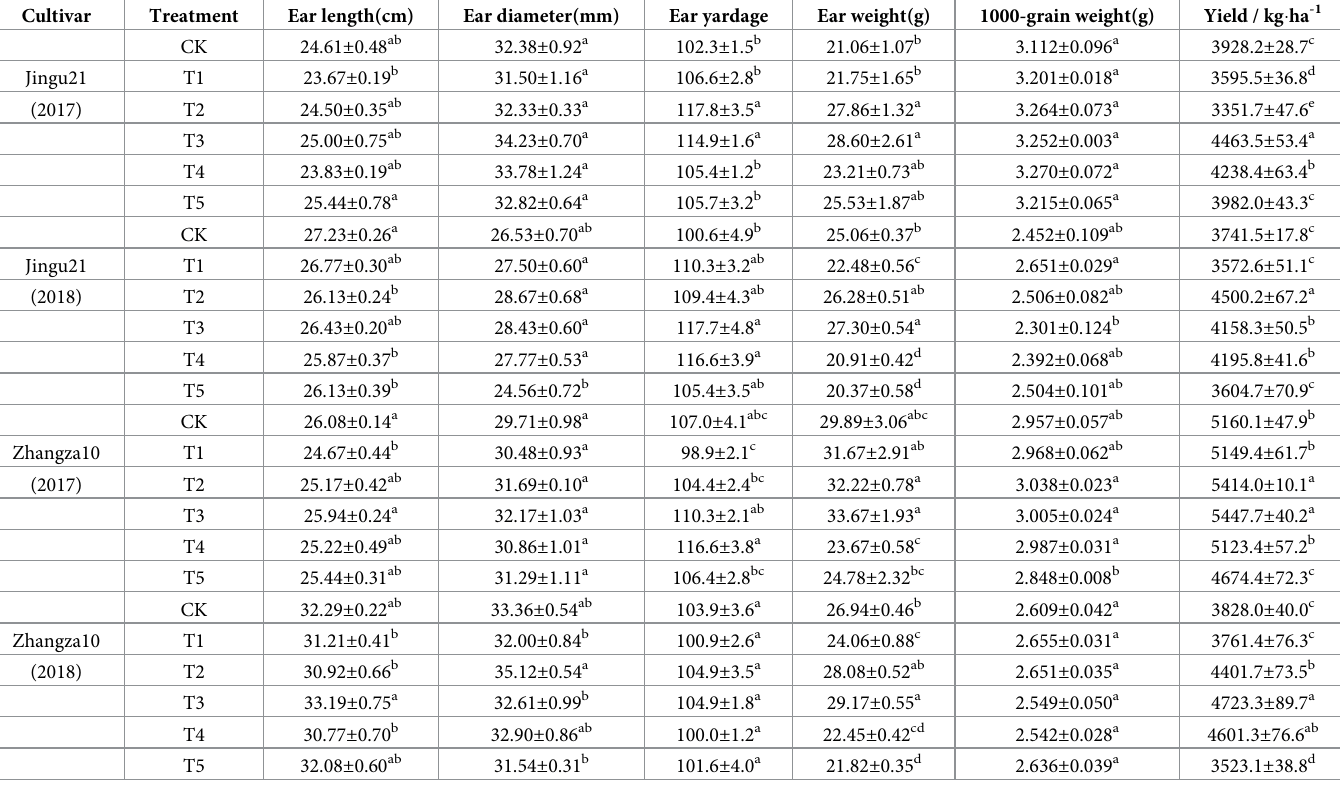
Table 1. Effect of HA on yield and yield composition of foxtail millet in 2017 and 2018. Cultivar